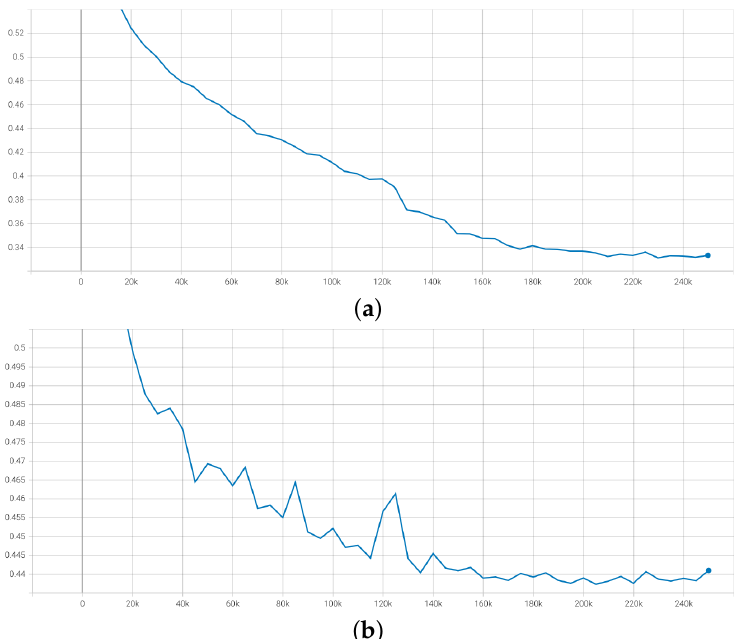
Figure 7. The loss curve of training and validation, respectively. ( a ) Loss curve for training dataset. ( b ) Loss curve for validation dataset.